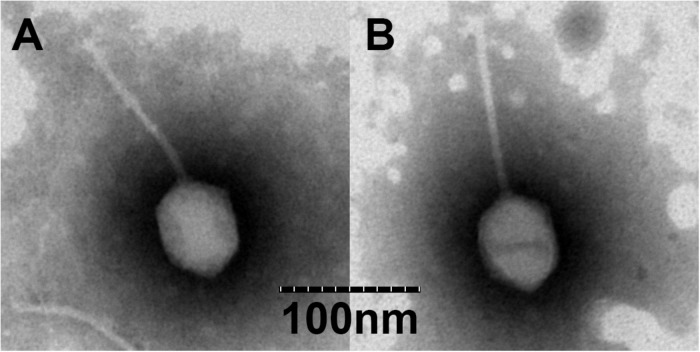
Transmission electron microscopy (TEM) of vB_VpS_BA3 (A) and vB_VpS_CA8 (B).